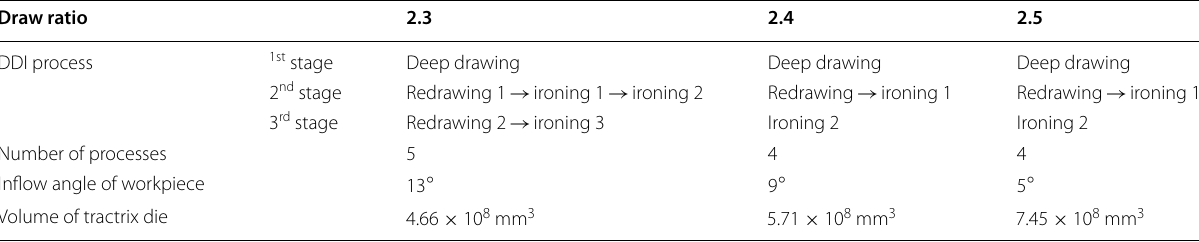
Table 7 Comparison of results according to draw ratios (2.3–2.5) in the 1 st deep drawing Draw ratio